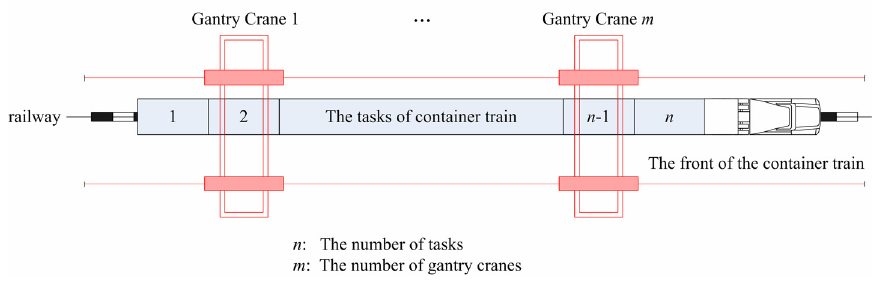
Fig. 2. Typical task partition of a container